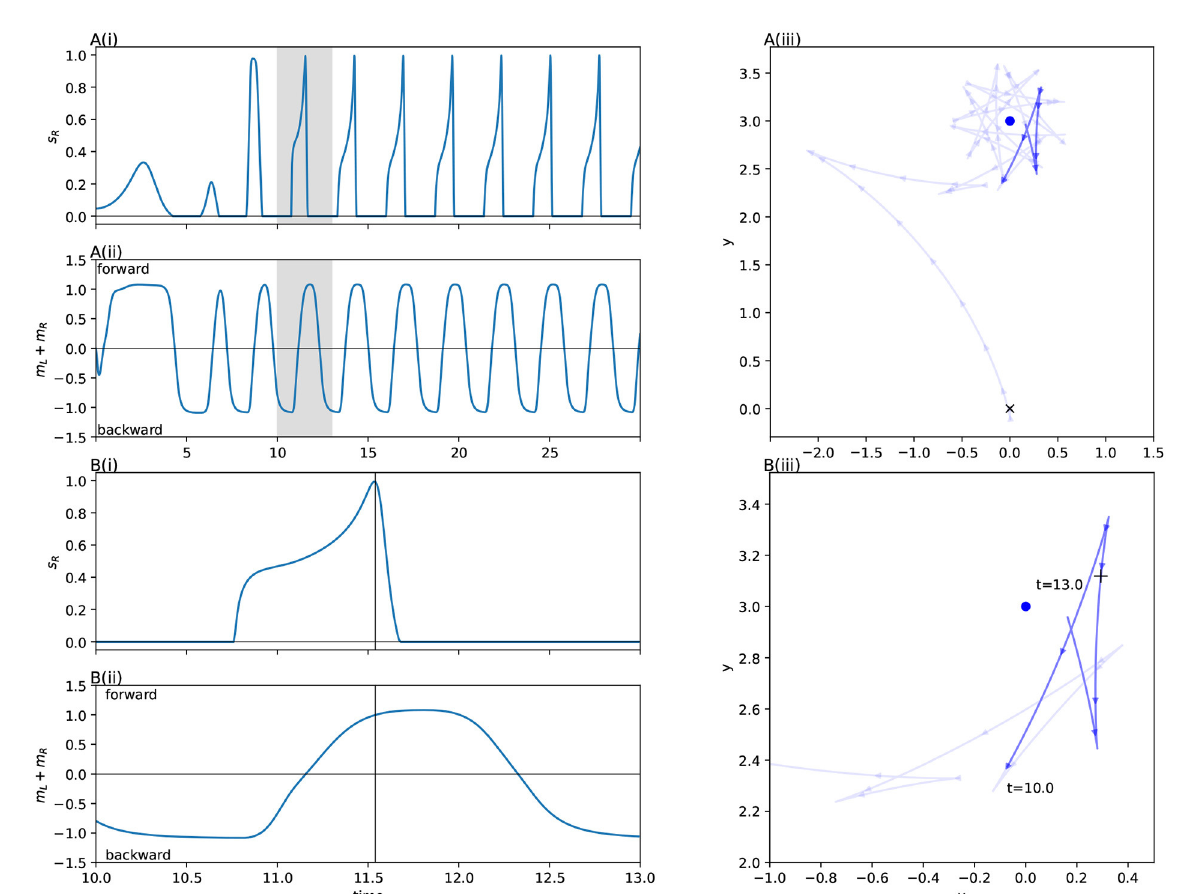
FIGURE4 Detail of the orbit phase (Phase B) for the ancestral solution. The plots marked (A) Show the ancestral solution when the light is at coordinates (0, 3)—position 12 in Figure 3. The highlighted sections of these figures mark the time period 10–13, which is shown in more detail in (B) . The vertical line in B(i,ii) marks the peak of right sensor activation, which corresponds to the + in B(iii) . The activity shown in (B) corresponds to the Phase B program (see main text). Before t 11, the robot drives backwards, passing the light on its right side. As the right sensor is stimulated, = the robot changes direction, driving forwards. After the right sensor stimulation peaks and dies down, the robot changes direction again, reversing toward the light. (A) Show how the process